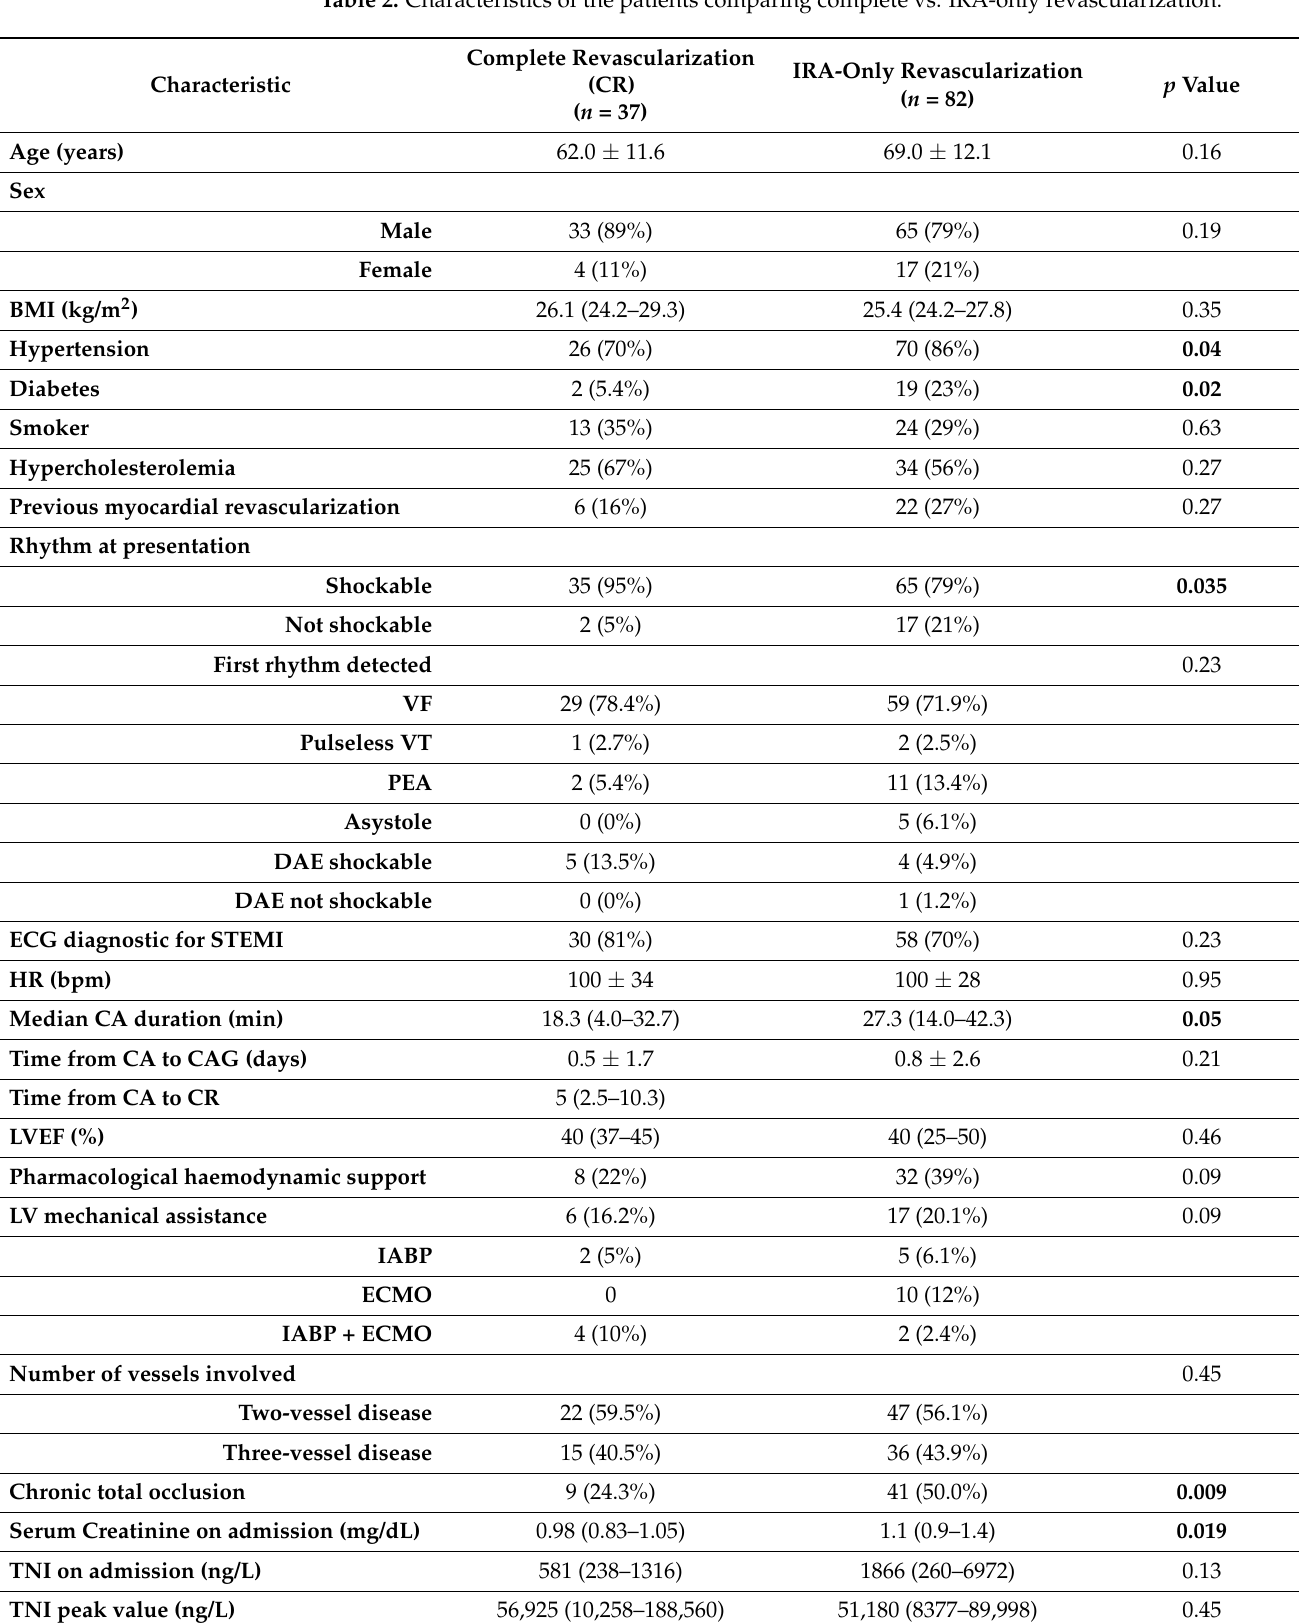
Table 2 compares the two groups (complete vs. IRA-only revascularization). Table 2. Characteristics of the patients comparing complete vs. IRA-only